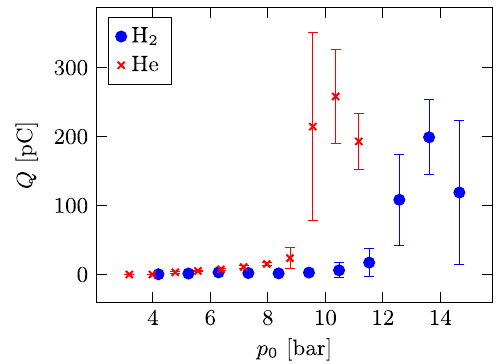
FIG. 2. Measured charge Q in the electron beams accelerated in a 2 mm gas jet over the scanned pressure range 3 – 15 bar in H 2 (blue circles) and He (red crosses) plotted as functions of the backing pressure. Each point represents the average of ten individual measurements with error bars indicating one standard deviation in each direction. Note that only electrons with an energy exceeding the cutoff (40 MeV) contributes to Q in this